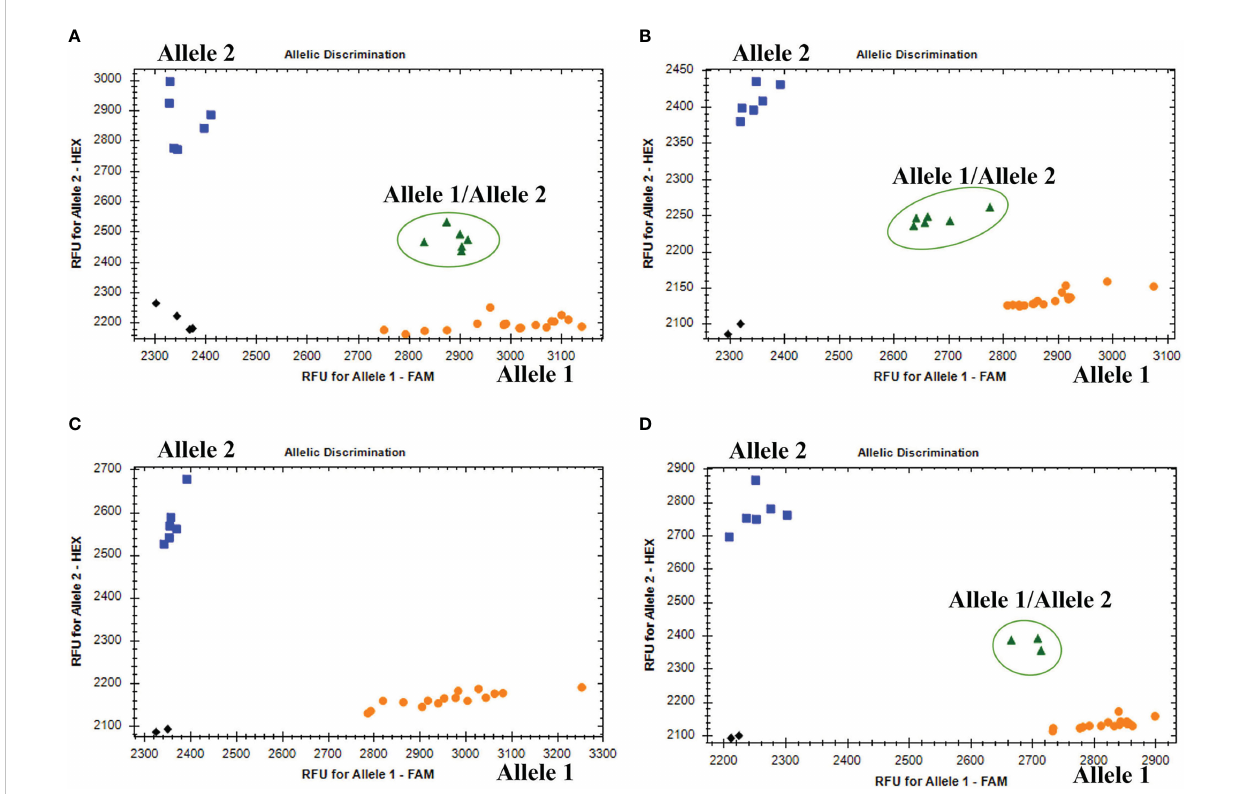
FIGURE 6 (A) Ampli fi cation results of marker KP2D-180993989 in CS, CS ph2b , wheat- P. huashania 3Ns, 4Ns, 7Ns addition lines (Allele 1); P. huashanica (Allele 2); wheat- P. huasahnica 2Ns addition lines (Allele 1/Allele 2). (B) Ampli fi cation results of marker KP7D-437429145 in CS, CS ph2b , wheat- P. huashania 2Ns, 3Ns, 4Ns addition lines (Allele 1); P. huashanica (Allele 2); wheat- P. huasahnica 7Ns addition lines (Allele 1/Allele 2). (C) Ampli fi cation results of marker KP2A-719278641 in P. juncea , Th. elongatum , A cristatum , D villosum , H vulgare , S. cereale , Pse. libanotica , Ley. racemosus (Allele 1); P. haushancia (Allele 2). (D) Ampli fi cation results of marker KP1A-440448839 in Th. elongatum , A cristatum , D villosum , H vulgare , S. cereale , Pse. libanotica (Allele 1); P. haushancia , P. juncea (Allele 2); Ley. racemosus (Allele 1/Allele